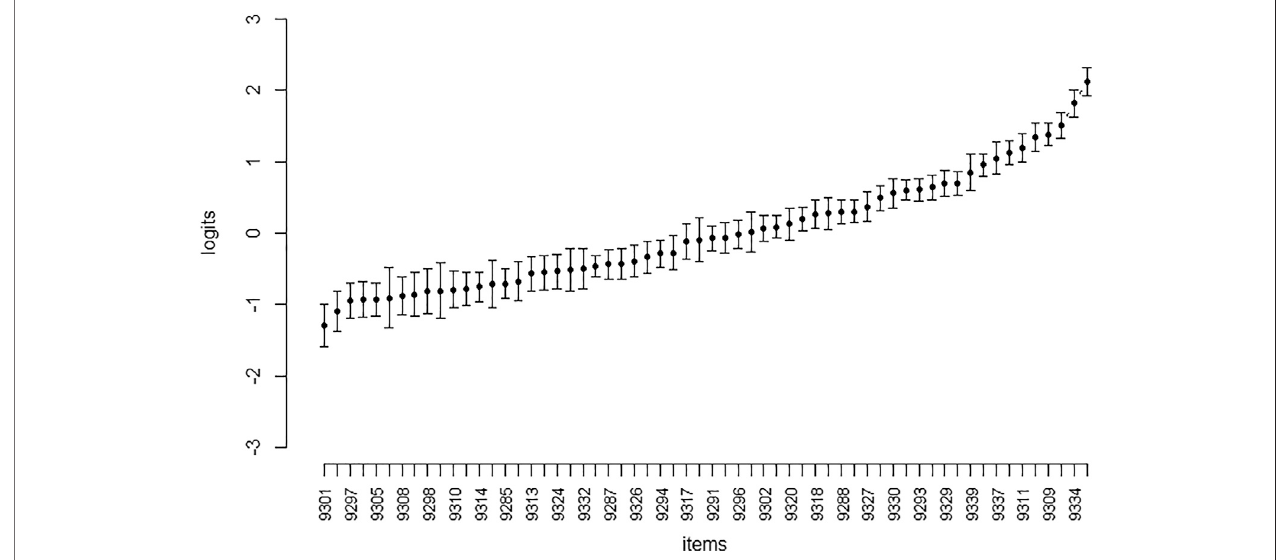
FIGURE 1 | Item Parameters (60 items; sorted by σ ). Note . On the Y -Axis the σ of the Items (in Logits) are given.